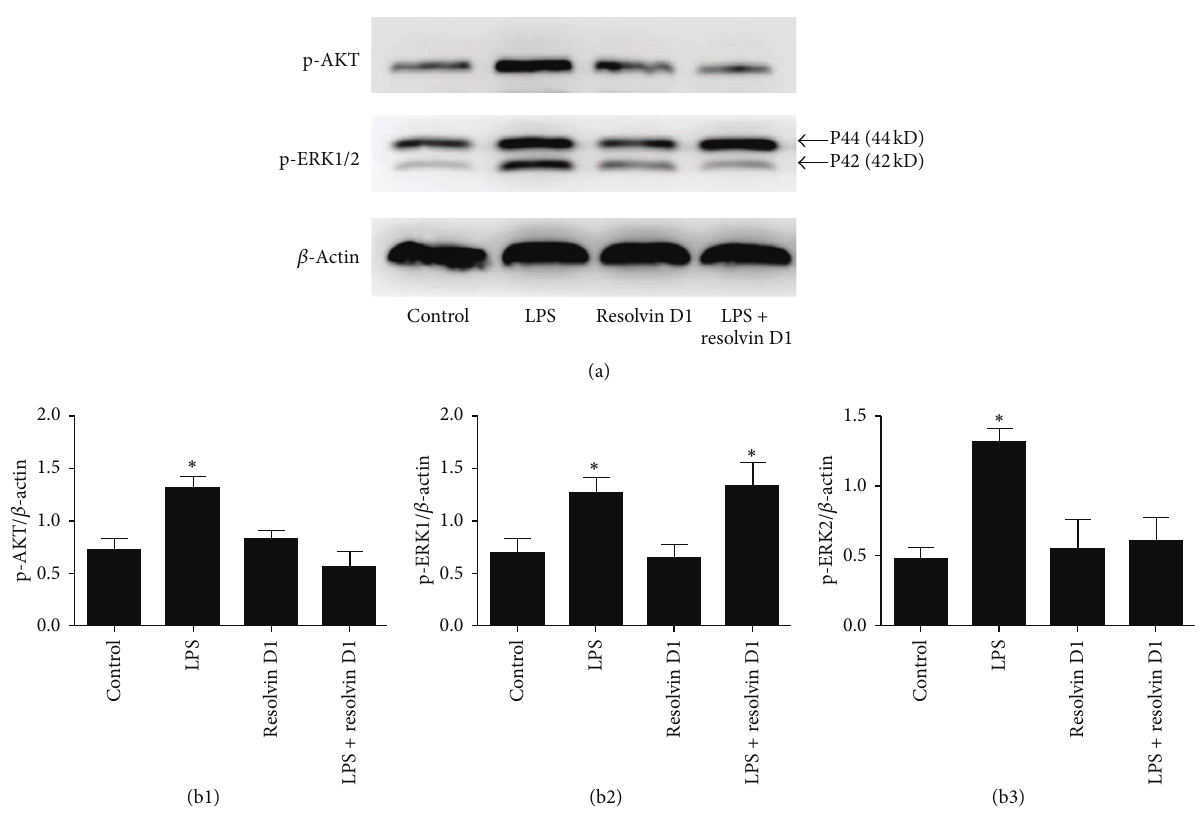
Figure 5: Resolvin D1 suppressed phosphorylation of PI3K/Akt in primary rat lung fibroblasts stimulated with LPS. Western blot analysis of P-AKT and phosphorylated ERK1/2. 𝛽 -actin served as a loading control. Cultured and serum-deprived primary rat lung fibroblasts were treated with lipopolysaccharide (LPS) for 30 minutes for P-AKT and phosphorylated ERK1/2 measurement, with or without preincubation with resolvin D1. ((a), (b1), (b3)) The expressions of p-AKT and the phosphorylated ERK2 (P42) were stimulated by LPS for 30 minutes in primary rat lung fibroblasts, significantly downregulated by resolvin D1 ( ∗ 𝑃 < 0.05 versus control, LPS + resolvin D1 groups). ((a), (b2)) However, no significant change in the expression of the phosphorylated ERK1 (P44) was observed between LPS group and LPS plus resolvin D1 group. Results shown are representative of four independent